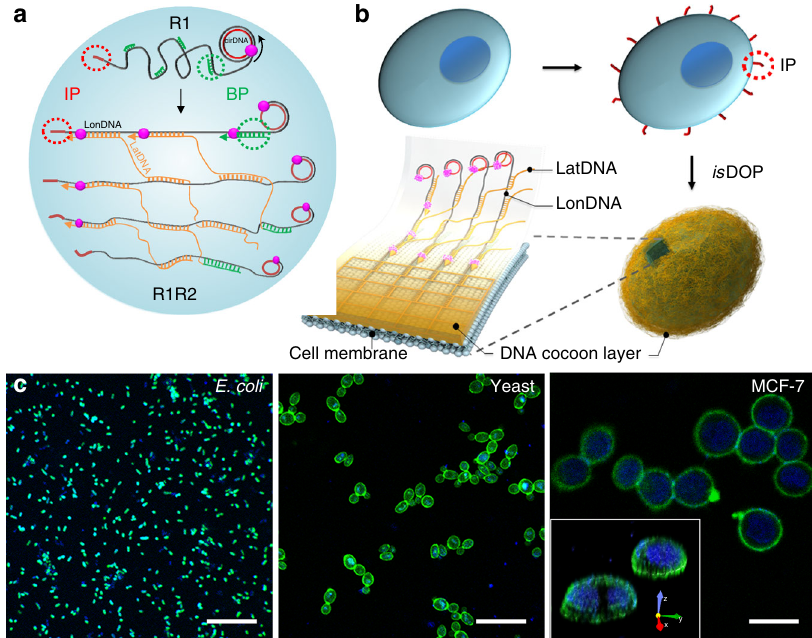
Fig. 1 In situ DNA-oriented polymerization reaction (isDOP) for cell encapsulation. a , b The isDOP contains two DNA replication reactions, R1 and R2. R1 is primed by the initiating primers (IPs), leading to the assembly of long initial polymers (LonDNA, gray). R2 is primed by the branched primers (BPs), leading to the branched replication that synthesizes the LatDNA polymers (yellow). Sequence-speci fi c assemblies across these LonDNA and LatDNA polymers fabricate the DNA cocoon at cell surface. c The scanning confocal microscope images show that typical cell types are encapsulated in the DNA polymer cocoons, including bacterial ( E. coli ), eukaryotic (yeast), and mammalian cells (MCF-7). The insert shows the reconstructed 3D-image of encapsulated MCF-7 cells. The surface-grafted DNA cocoons are labeled with FAM-modi fi ed oligonucleotides (green). The cell nuclei are stained with Hoechst 33342 (blue). Scale bar, 20 μ